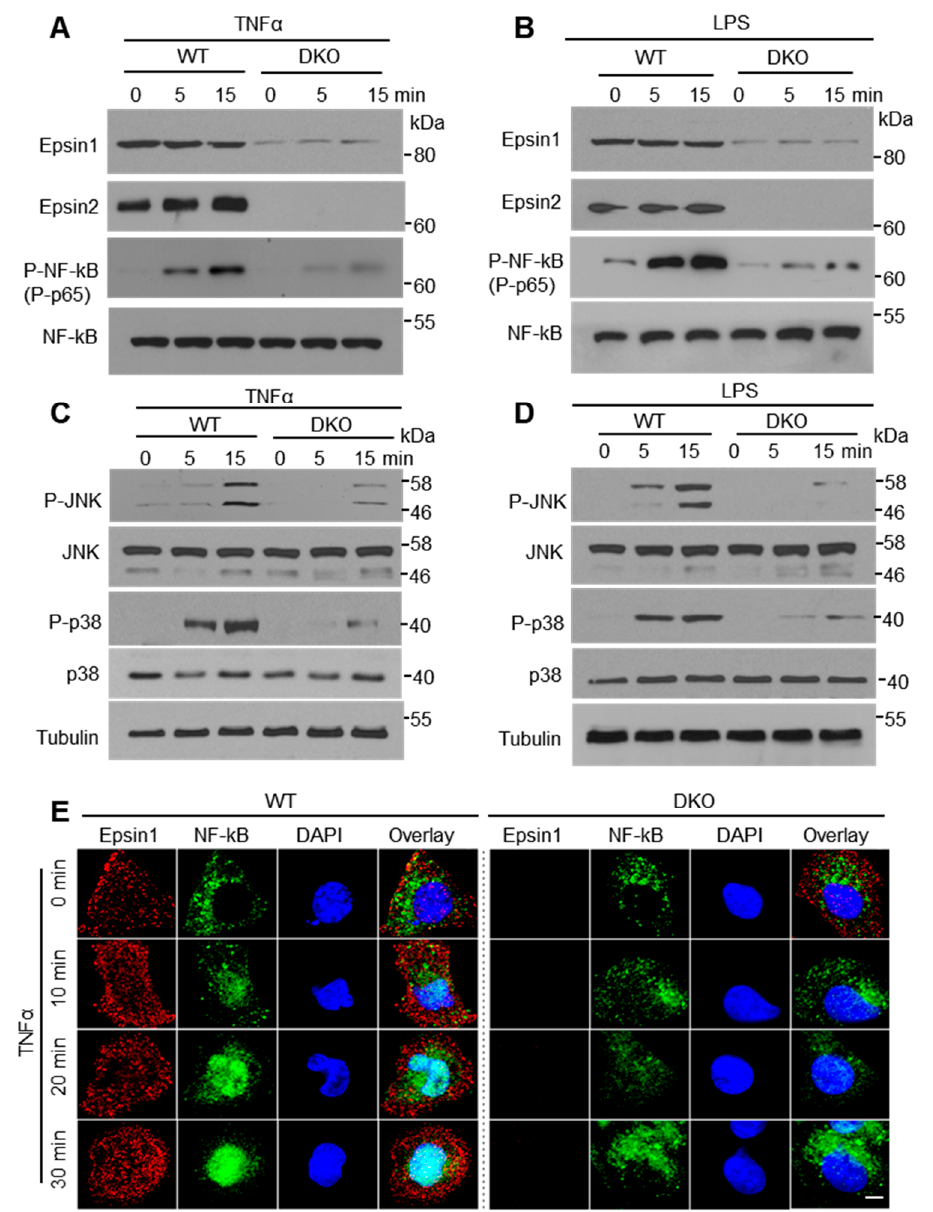
Figure 1. Loss of epsins in MAECs attenuates inflammatory signaling. ( A , B ) Western blot analyses of NF- κ B (p65) signaling induced by TNF- α (50 ng/mL) or LPS (1 µg/mL) (n = 4). ( C , D ) Western blot analyses of MAPK (p38 and JNK) signaling induced by TNF- α (50 ng/mL) or LPS (1 µg/mL) (n = 4). ( E ) NF- κ B (p65) translocation in WT or DKO MAECs stimulated with 50 ng/mL TNF- α for the indicated time (n = 4). Scale bar = 10 µm.